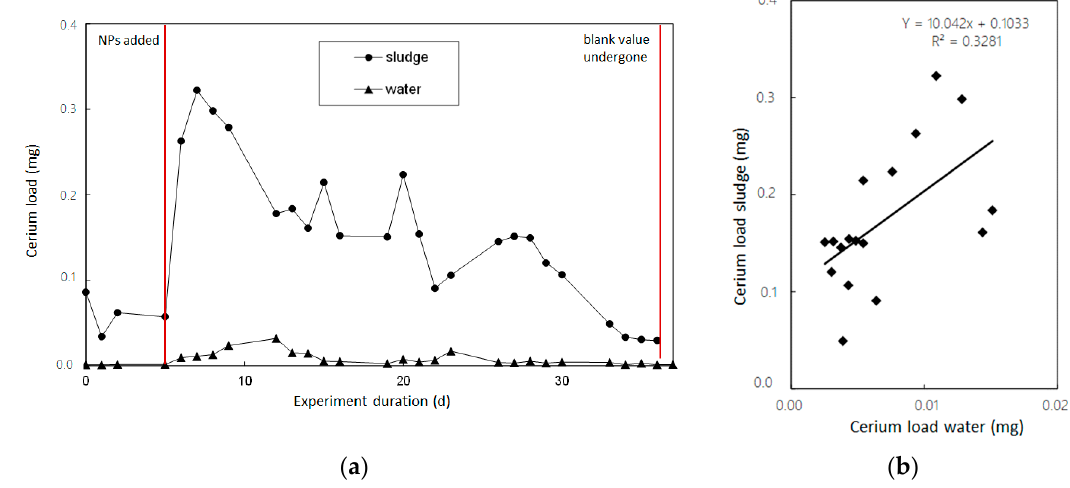
Figure 5. Discharge loads of cerium NP after single particle addition on test day 5. ( a ) Cerium load over experiment duration, ( b ) correlation between cerium load in water and sludge.